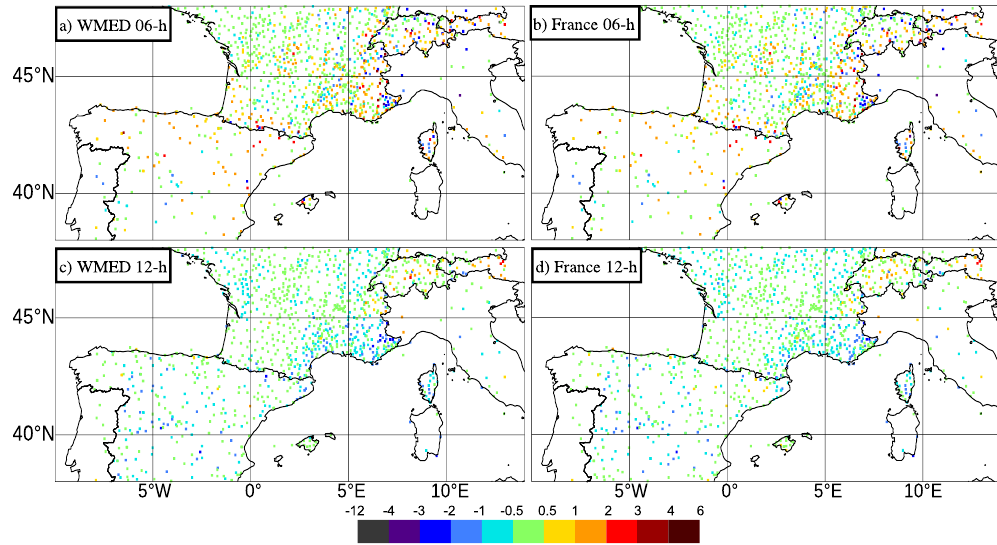
Figure 8. The 2m temperature bias (model–observation, in ◦ C) computed with surface data for the 6 and 12h forecast ranges for the SOP1 period ranging from 07 September to 05 November 2012, for AROME-WMED (left) and for AROME-France (right).